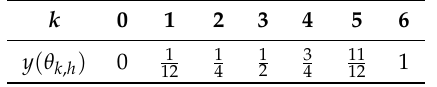
Table 2. Example 1: The unknowns y ( θ k , h ) ≡ θ k , h , 0 ≤ k ≤ 6.